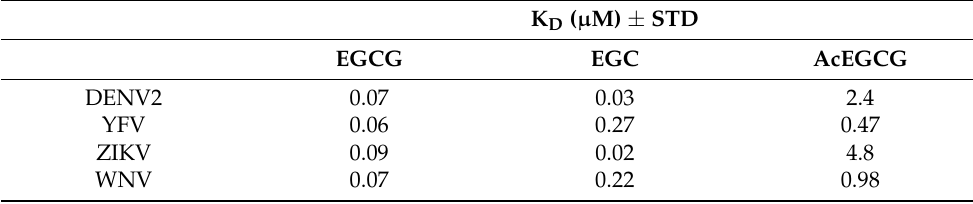
Table 7. K D values of the molecules in complex with the NS2B/NS3 pros by SPR